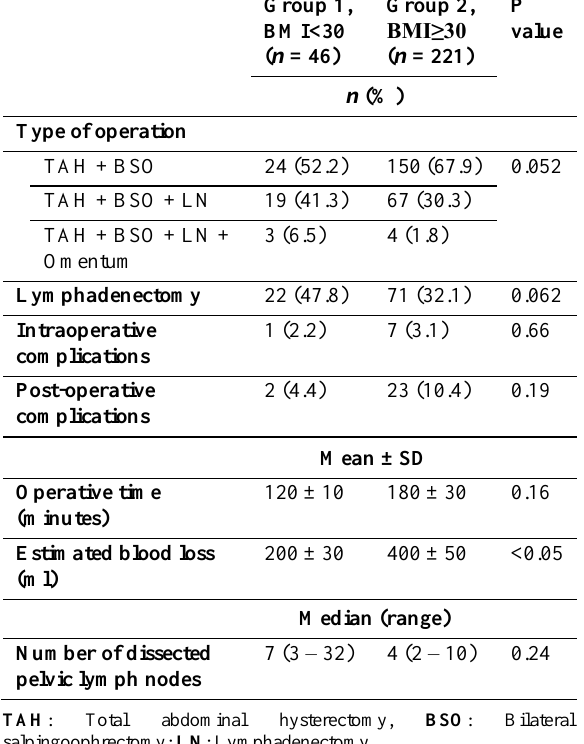
Table 2: Operative data and complications according to obesity